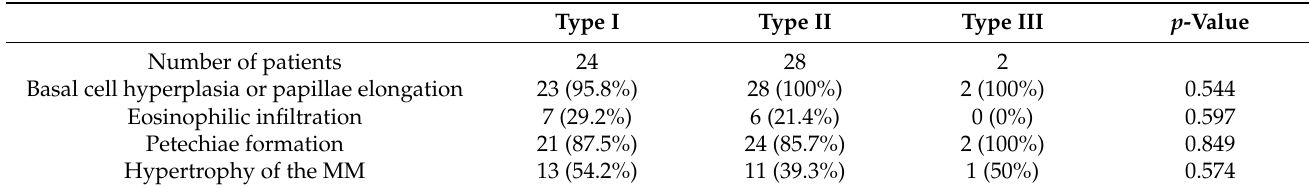
Table 3. Histopathology of achalasia subtypes.